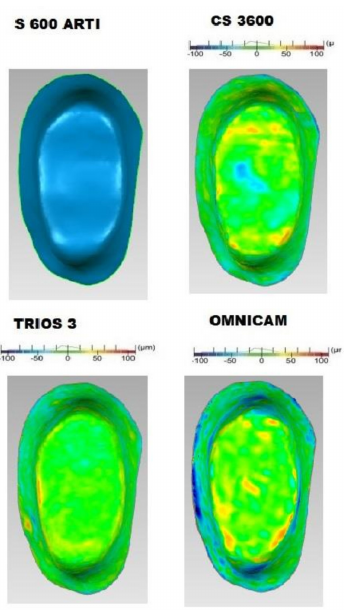
Figure 8. Comparison of complete preparation in OVA rendering S600ARTI and 3D comparison analysis for IOS without saliva in relation to the sample 4. Nominal histogram settings ± 25 microns and critical ± 100